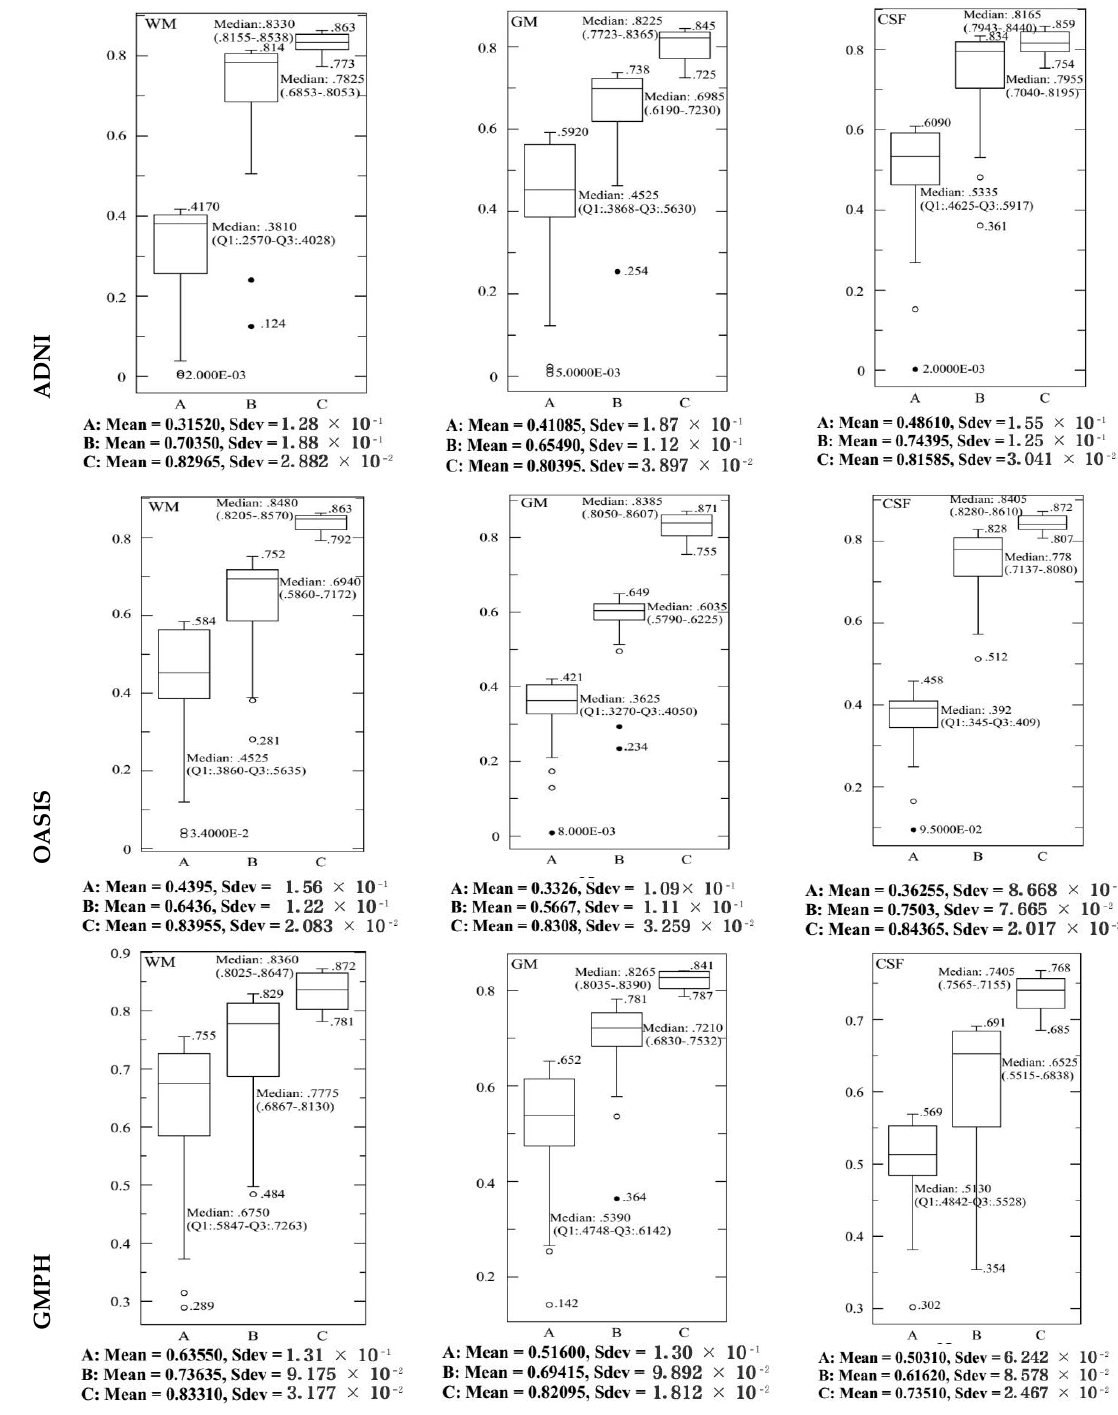
Figure 12. The corresponding Box-and-whisker plots of the descriptive statistics of the measured JS values (95% confidence interval) for WM, GM and CSF tissues with 20% additive noise. 20 experiences are used to evaluate the following modelling approaches: BCFCM/GA/PFCM ( C ), BCFCM/GA/FPCM ( B ) and BCFCM/GA/PCM ( A ).